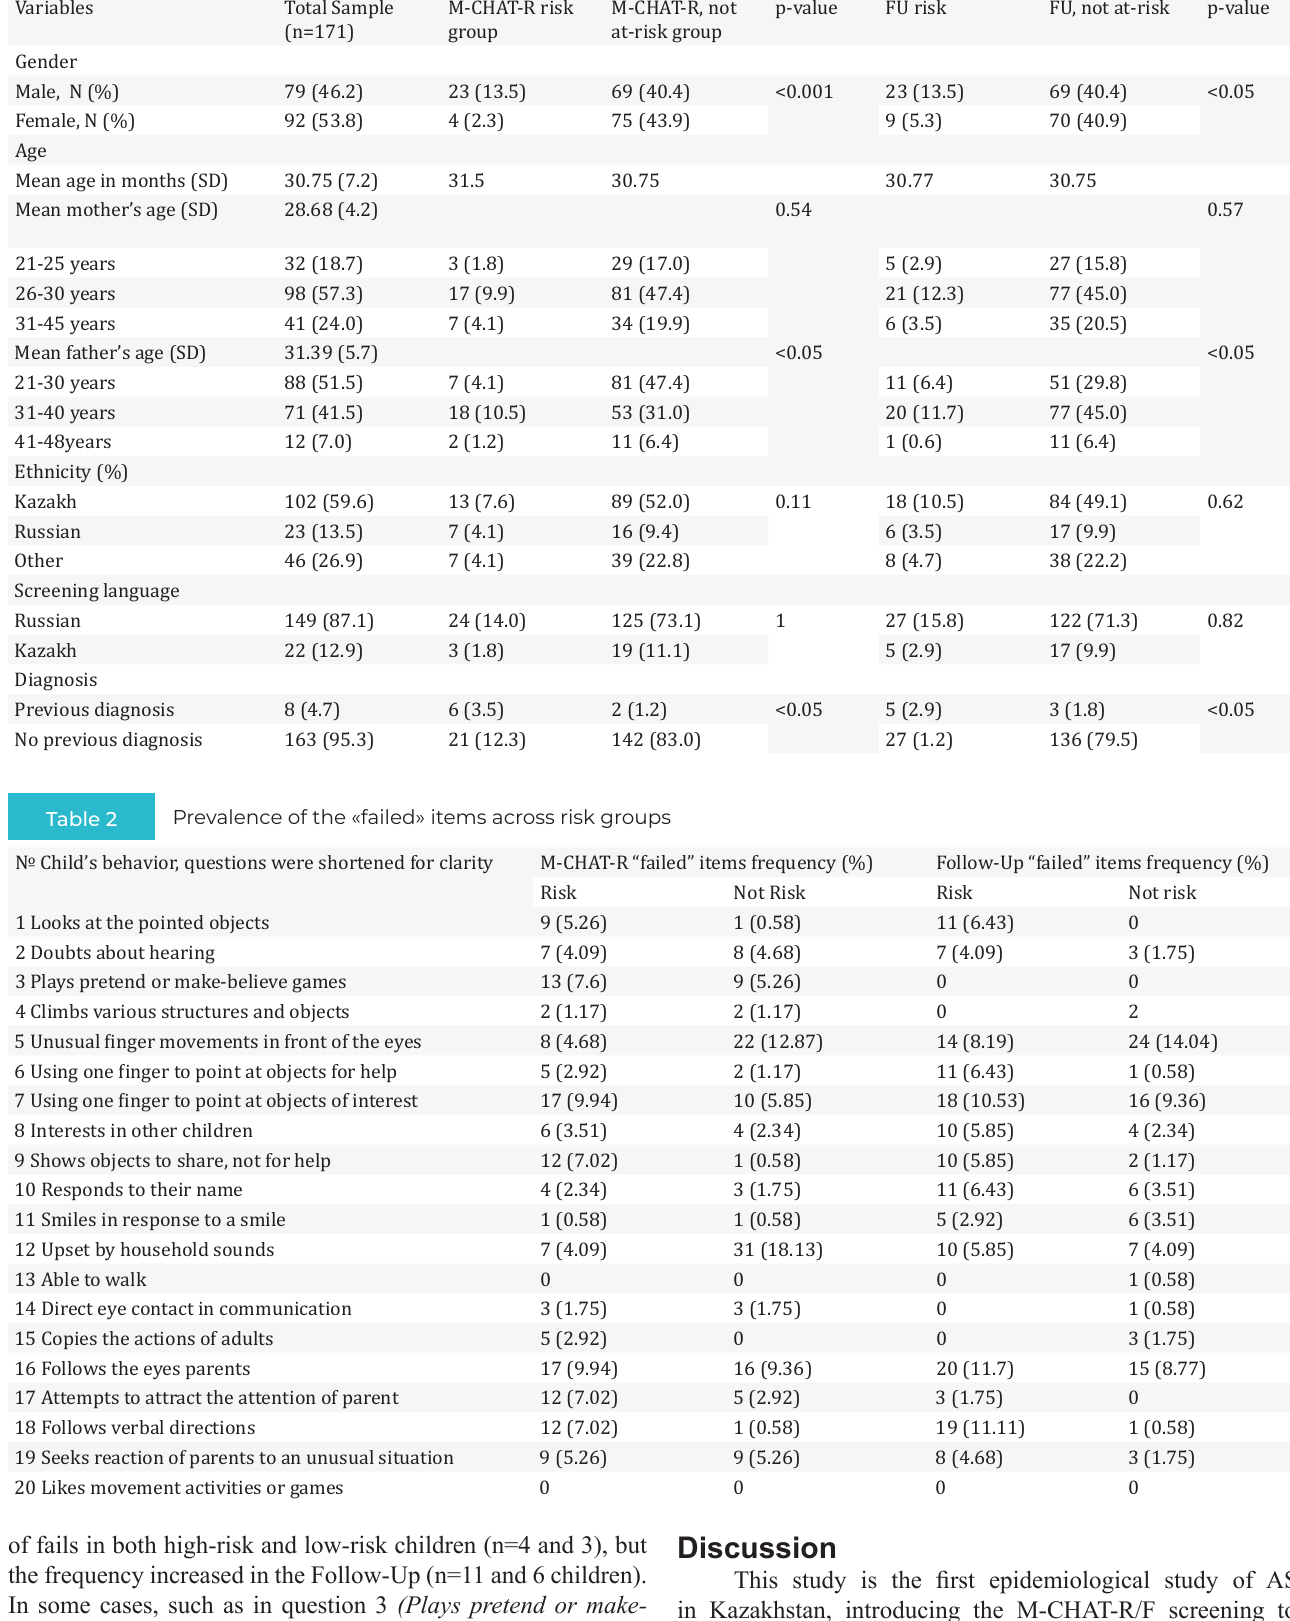
M-CHAT-R and Follow-Up (FU) results and demographic characteristics of the sample